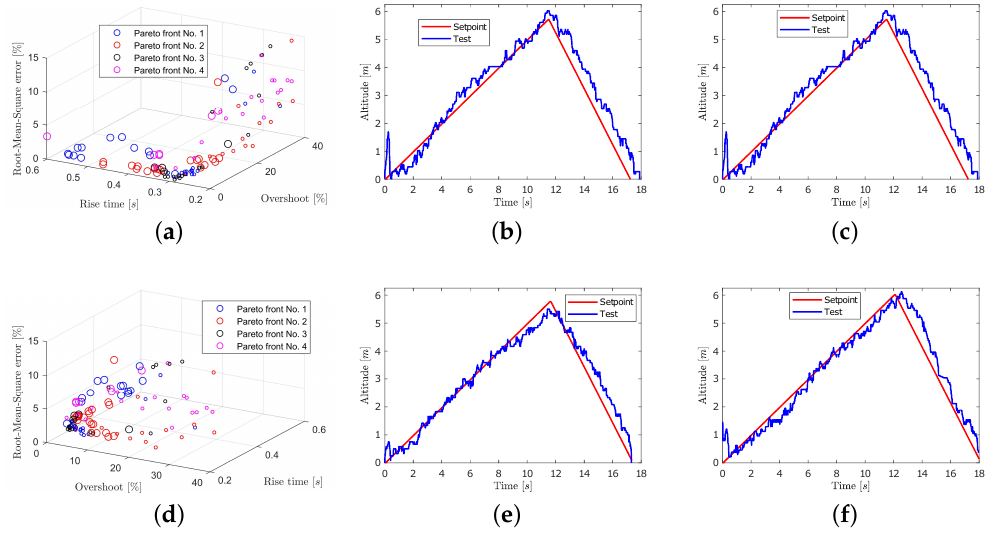
Figure 11. Results obtained for the altitude axis. ( a ) Pareto front (the bigger particles represent the ones without oscillation hazard). ( b ) Experimental response (test number 1.) ( c ) Experimental response (test number 2.) ( d ) Pareto front for the yaw axis in a different perspective. ( e ) Experimental response (test number 3.) ( f ) Experimental response (test number